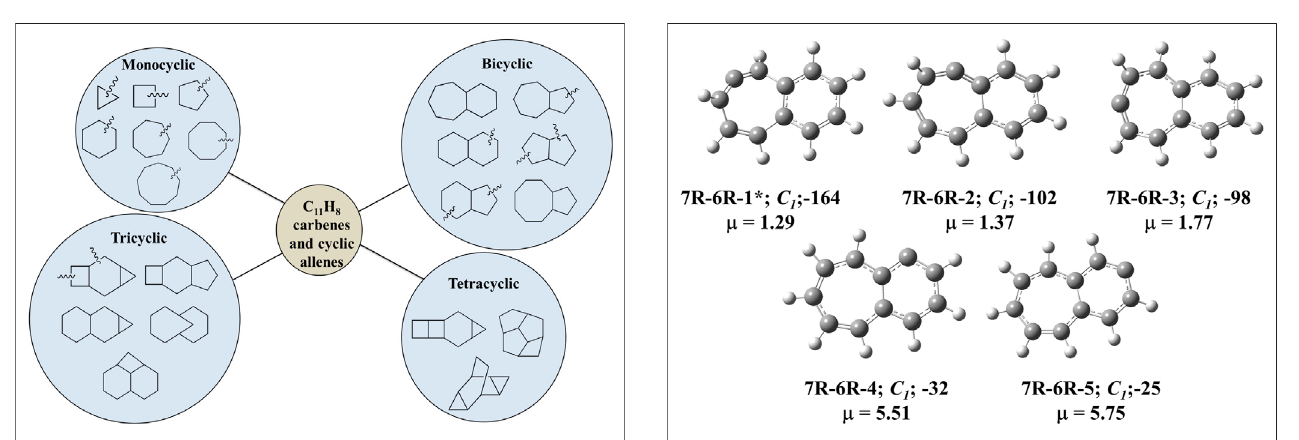
FIGURE 2 | All low-lying C 11 H 8 carbenes/cyclic allenes isomers with seven-membered and six-membered fused ring system i.e., (7R-6R) group. ZPVE-correctedrelativeenergies(inkJmol − 1 ),absolutedipolemomentvalues (in Debye) are calculated at the B3LYP/6-311 + G (d,p) level of theory. Experimentally detected isomers are marked with an asterisk symbol.